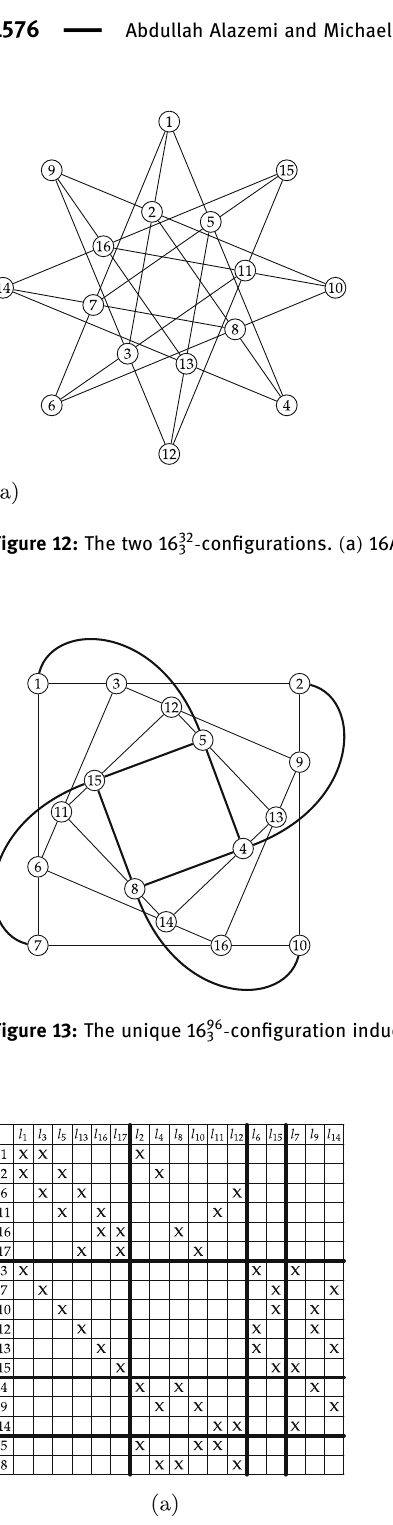
Figure 14: The incidence matrices of ( a ) the unique triangle - free 17 3 - con fi guration and ( b ) a self - polar 17 3 - con fi guration with 14